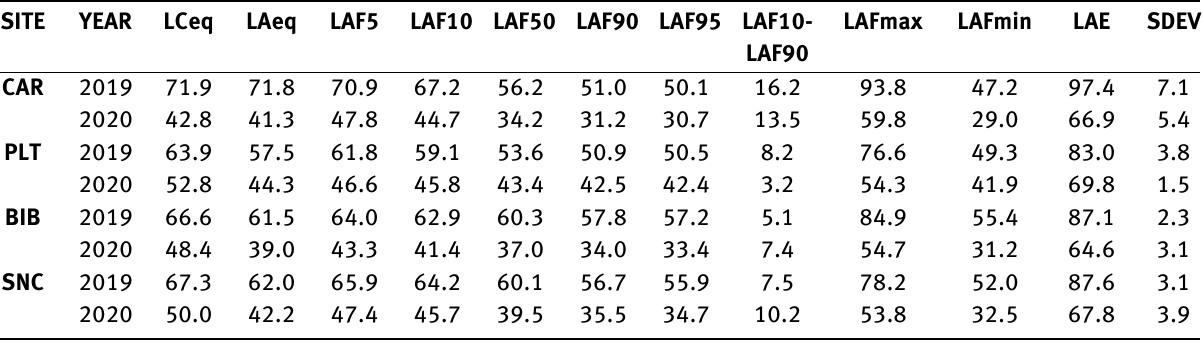
Table 3: Summary environmental noise indices data in Granada, before (2019) and during lockdown (2020) at four selected sites SITE